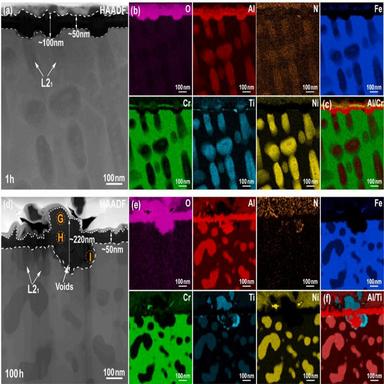
The HAADF and STEM-EDS analysis of the cross-section oxide scale of Al16 CCA after 1 h and 100 h oxidation at 800 ◦C in air. (a) HAADF image, (b) EDS mappings, (c) EDS mapping superposition of Al and Cr elements, after 1 h oxidation; (d) HAADF image, (e) EDS mappings, (f) EDS mapping superposition of Al and Cr elements, after 100 h oxidation.